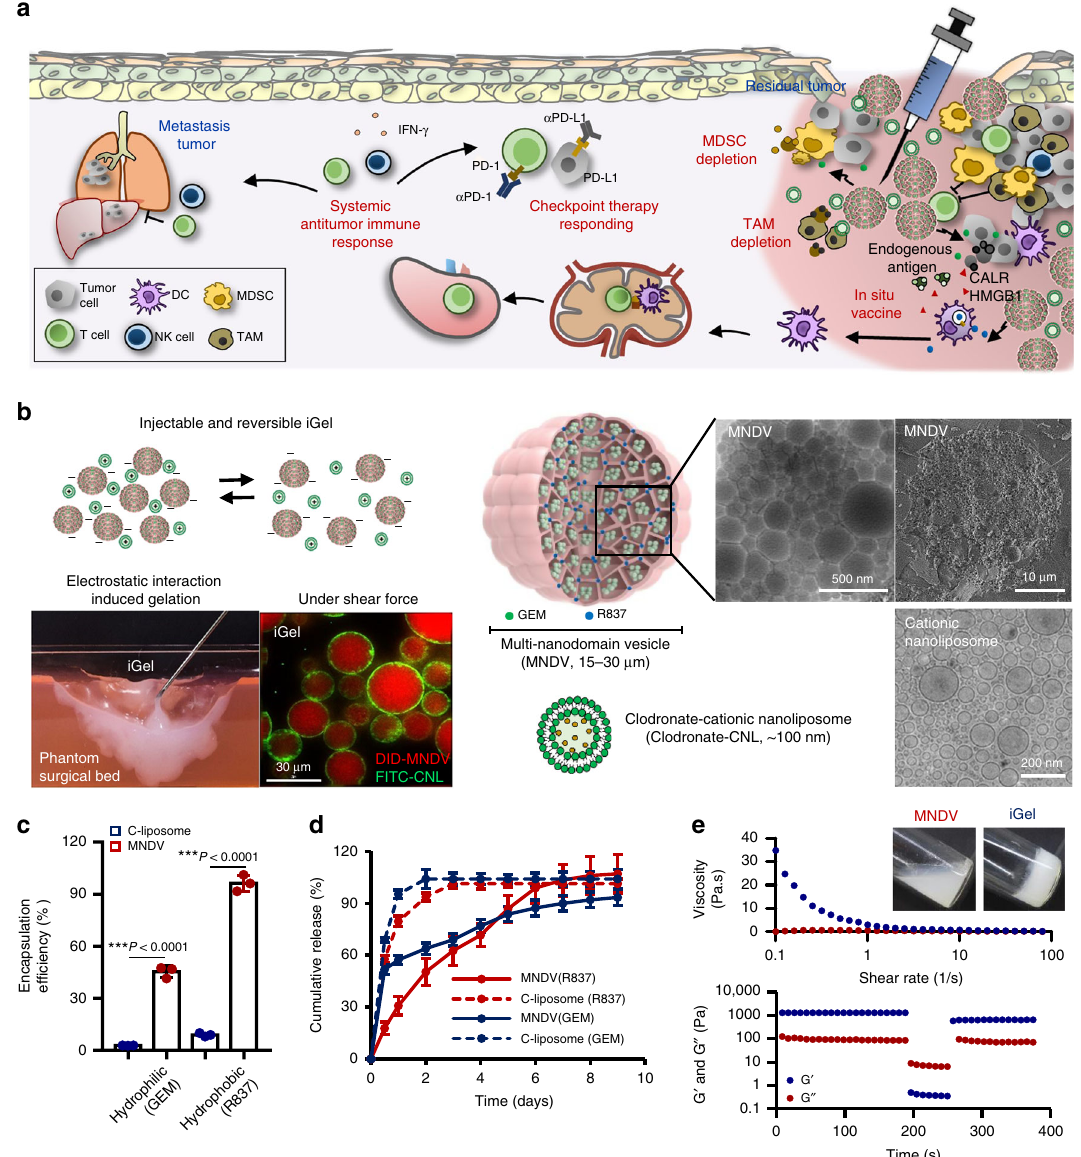
Fig. 1 MNDV and syringeable iGel for post surgical local treatment. a Schematic depiction of iGel for the prevention of post operative tumor recurrence and metastasis. Gemcitabine (GEM) and clodronate-CNLs act as MDSC-, and TAM-depleting drugs to revert the immunosuppressive microenvironment. Release of the vaccine, R837, and an endogenous antigen provide immunostimulation and elicit an antitumor immune response. Moreover, combination treatment with checkpoint therapy can help to boost the immune response against cancer cells. b Left: schematic illustration of injectable and reversible iGel. A photograph image represents the characteristic of iGel in easy injectability onto irregular cavity in phantom surgical bed and fl uorescent images of the gel showing that DID-loaded MNDVs were interconnected by FITC-labeled CNLs. Right: schematic of MNDV and CNL. The inset shows a transmission and scanning electron cryomicrographs of the structure of MNDVs and CNLs. c Comparison of hydrophilic (GEM) and hydrophobic (R837) drug encapsulation ef fi ciency in MNDVs versus conventional liposomes (C-liposomes). d Kinetics of drug release from MNDVs and C-liposomes. P- values were analyzed by Student ’ s t -test ( n = 3). e Rheological properties of iGel. Viscosity over shear rates of MNDVs versus the gel (upper). Recovery of the gel undergoing cyclic deformation of 0.2 and 500% strain with G ′ and G ″ (lower). The results are representative of one of three independent experiments. Source data are provided as a Source Data fi